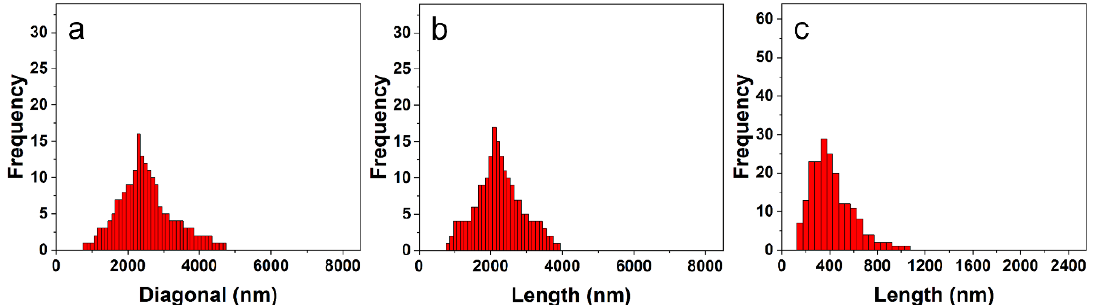
Figure 2. The size distributions of the nanostructures self-assembled by P3HT 22 - b -PEG 43 ( a , b ) and P3HT 22 - b -PEG 113 ( c ) in i -PrOH with the polymer concentration at c = 0.005 mg . mL − 1 . ( a ) The diagonal length distribution of the multilayered hierarchical micelles. ( b ) The length distribution of the 2D laminar layers included in multilayered hierarchical micelles. ( c ) The contour length of the fibers.